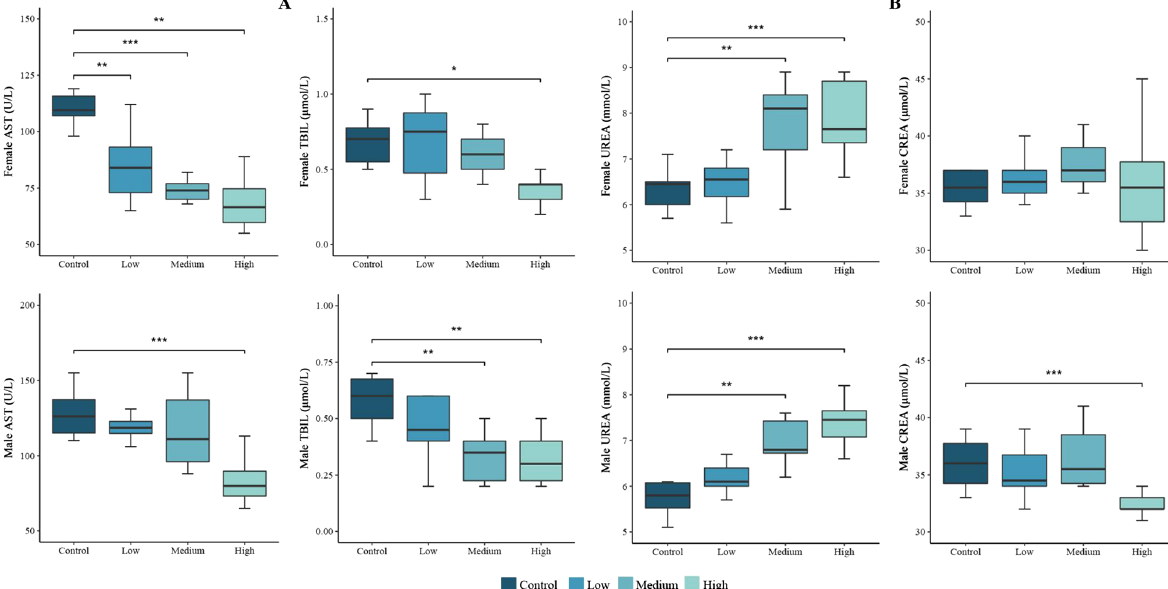
Fig. 2 Changes in blood biochemical parameters of rats exposed for 90 days to different doses of the maleic acid polymer scale inhibitor. A Changes in AST and TBIL, related to liver function. B Changes in UREA and CREA, related to kidney function. All values are expressed as the mean SD per group ( n 20, 10 male and 10 female). The Shapiro–Wilk test was used to assess normality, and Bartlett’s test was used to assess ± = homogeneity of variance. Dunnett’s test was used in the case of homoscedasticity and a normal distribution, and the Wilcoxon rank–sum test was used in the case of heteroscedasticity or a skewed distribution for statistical analysis comparing with the control group. Significance was determined at p < 0.001***, p < 0.01** and p <